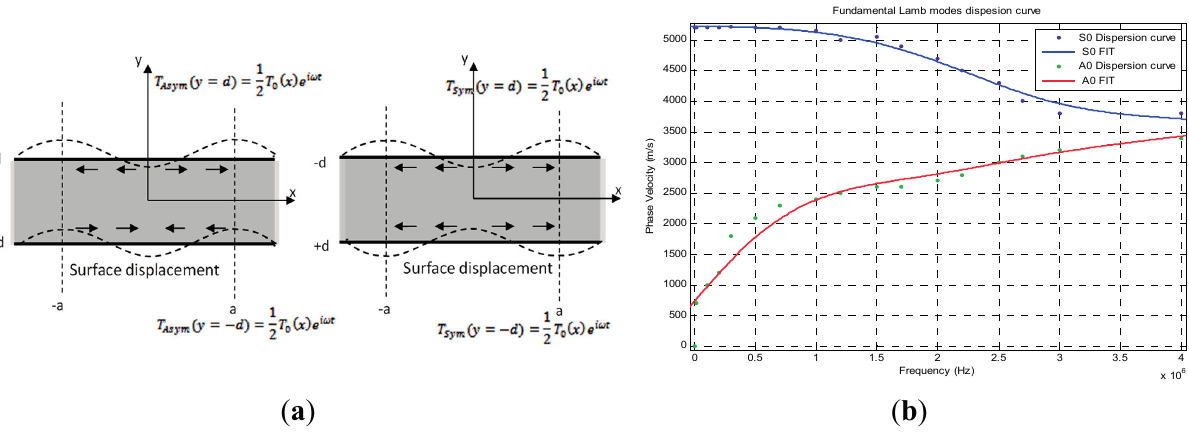
Figure 13. ( a ) Typical structure of fundamental symmetric and anti-symmetric Lamb wave